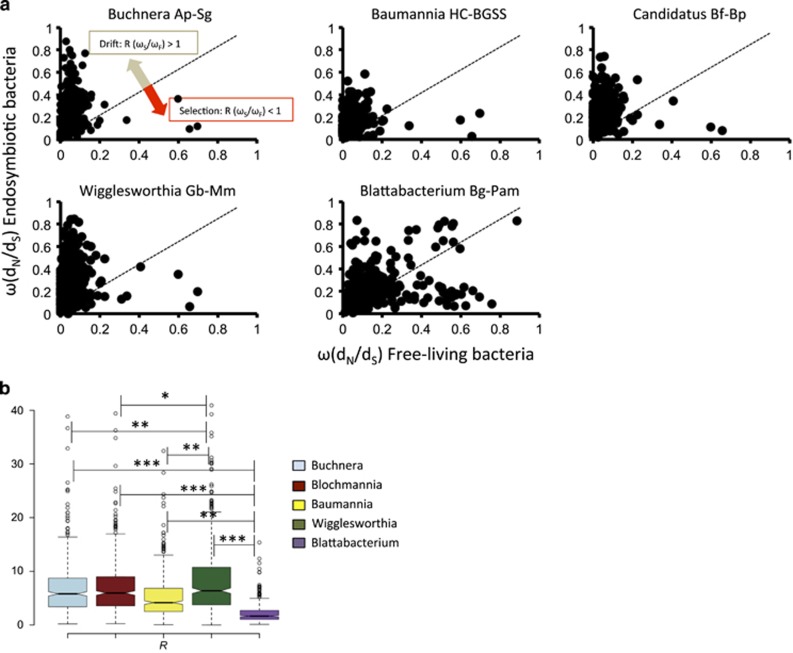
Signatures of natural selection and genetic drift in endosymbiotic bacteria of insects. The strength of selection was determined as the ratio between non-synonymous nucleotide substitutions per non-synonymous site (dN) and synonymous nucleotide substitutions per synonymous site (dS) (ω=dN/dS) for each genome pair. (a) To determine the relative strength of selection on endosymbiotic genomes, we divided the ω of each symbiotic gene (ωe) by that of its ortholog in its free-living bacterial relatives (ωf) and compared this ratio (R) with 1. Values of R>1 imply that ωe>ωf, hence endosymbiotic genes evolved under relaxed selective constrains or under increased genetic drift. Conversely, R<1 implies stronger constrains on endosymbiotic genes than on their free-living bacterial orthologs. (b) The relative efficiency of natural selection, or genetic drift, for each of the endosymbiotic genomes of this study was compared. Differences were tested using Wilcoxon's rank test with significant values being indicated with *P<0.05, **P<0.01 and ***P<10−6.